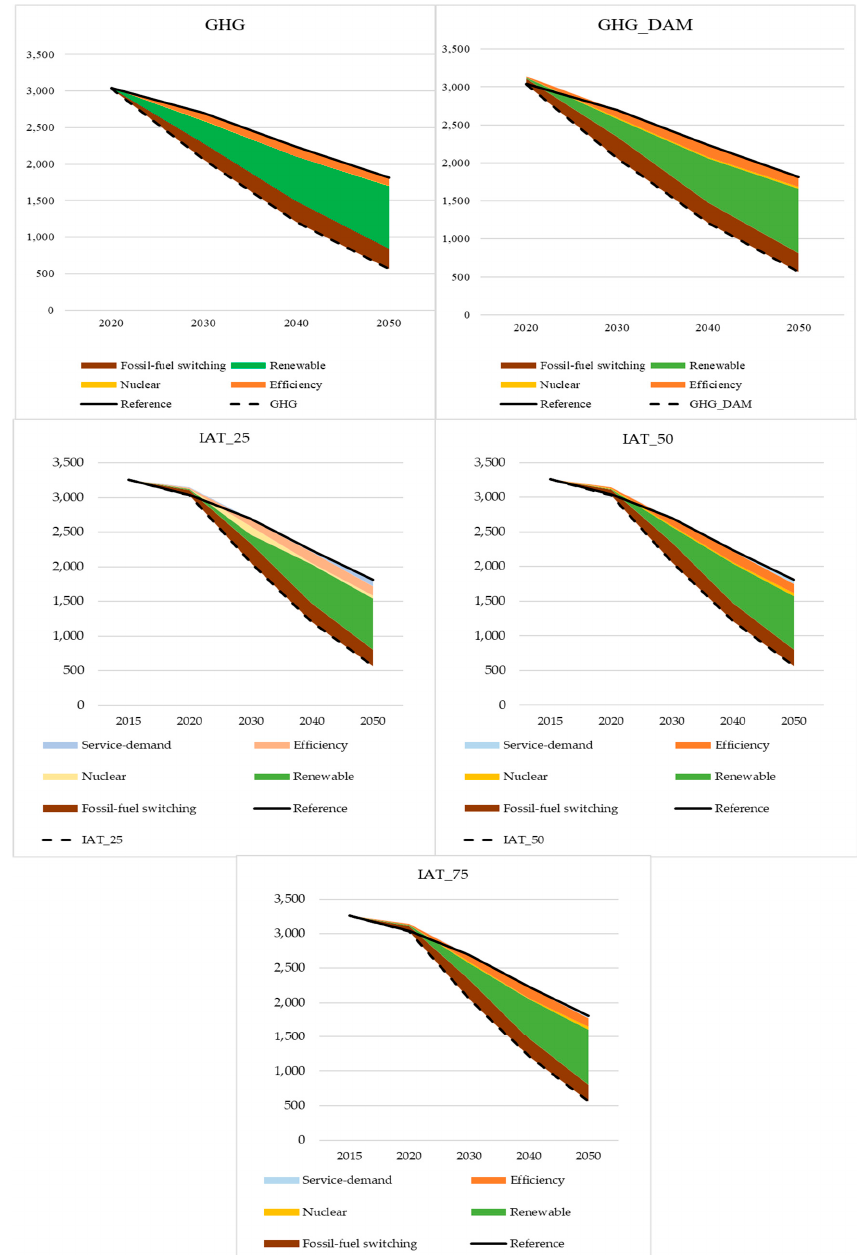
Figure C1. CO 2 Decomposition (Mt) — total system in the EU28. Figure A4. CO 2 Decomposition (Mt)—total system in the